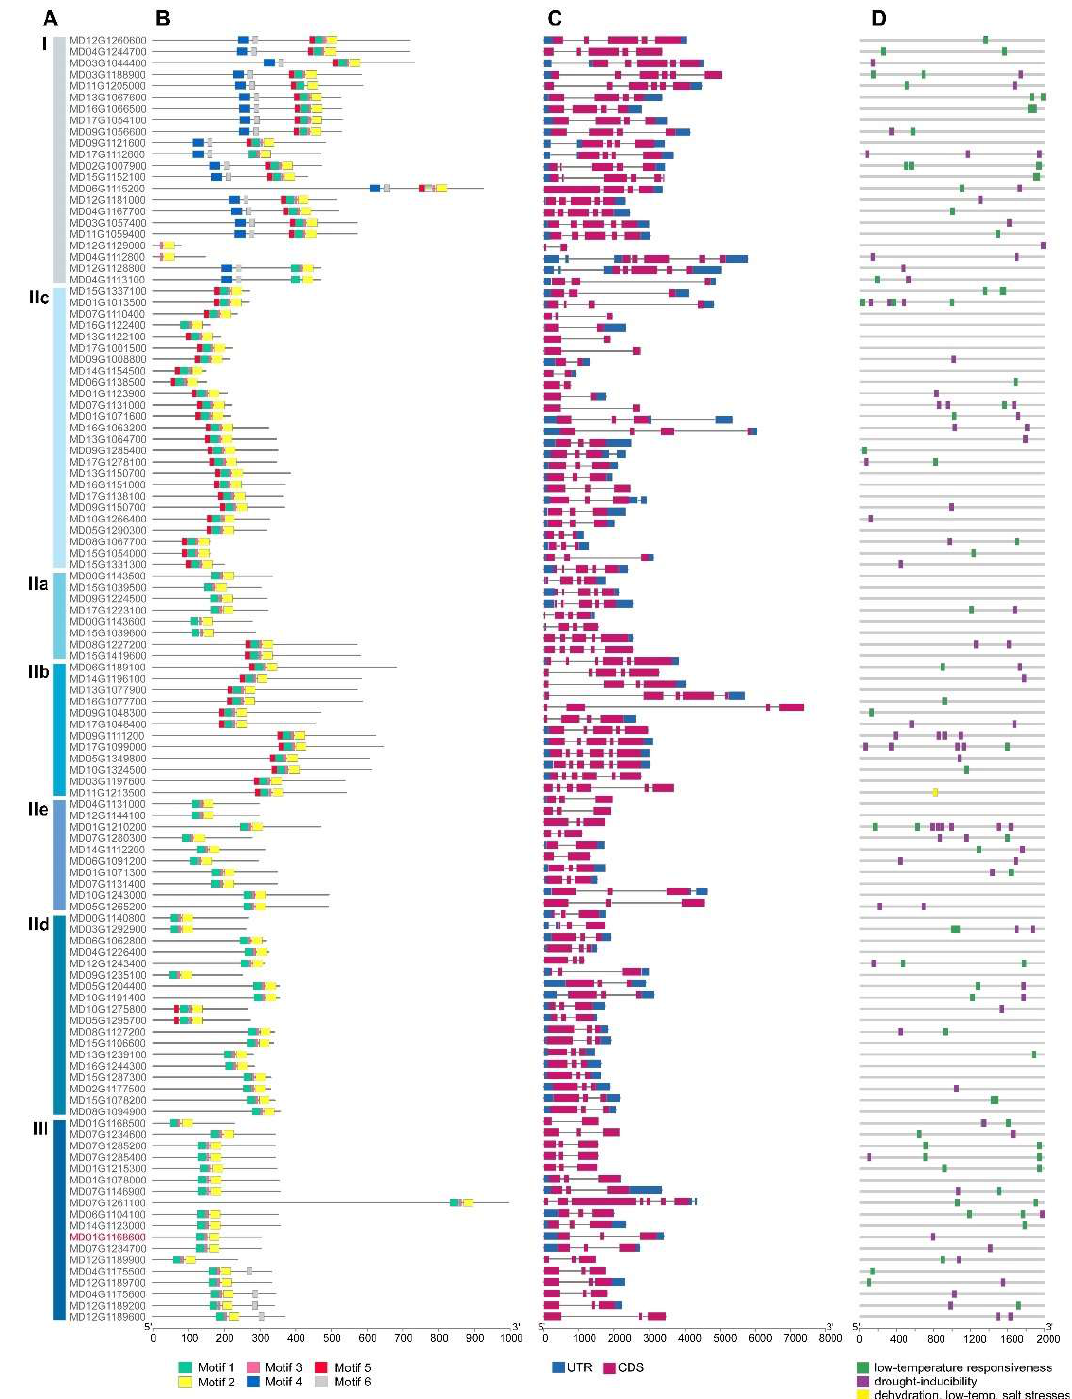
Figure 4. Phylogenetic tree, protein motif, gene structure and cis-acting element analysis of MdWRKY genes. ( A ) Phylogenetic tree. Phylogenetic tree was constructed using MEGA-X program with the neighbor-joining (NJ) method; ( B ) Protein motifs. The conserved motifs were identified by MEME. Each motif was represented by a colored box, the sequence information for each motif is provided in supplementary Table S3; ( C ) Gene structures. Data in GFF3 format was downloaded from JGI and analyzed using TBtools. CDS, UTR and intron are represented by pink mauve box, dark blue box and grey line, respectively; ( D ) Cis-acting element prediction. Cis-element prediction was performed using PlantCARE. Only those related to stresses were selected for visualization and the rest were not displayed. The visualization of the results was achieved using TBtools. MdWRKY70L (MD01G1168600) are marked with red.